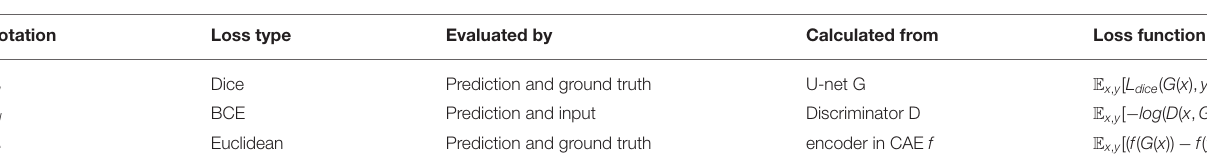
TABLE 1 | Loss in the proposed FSPET